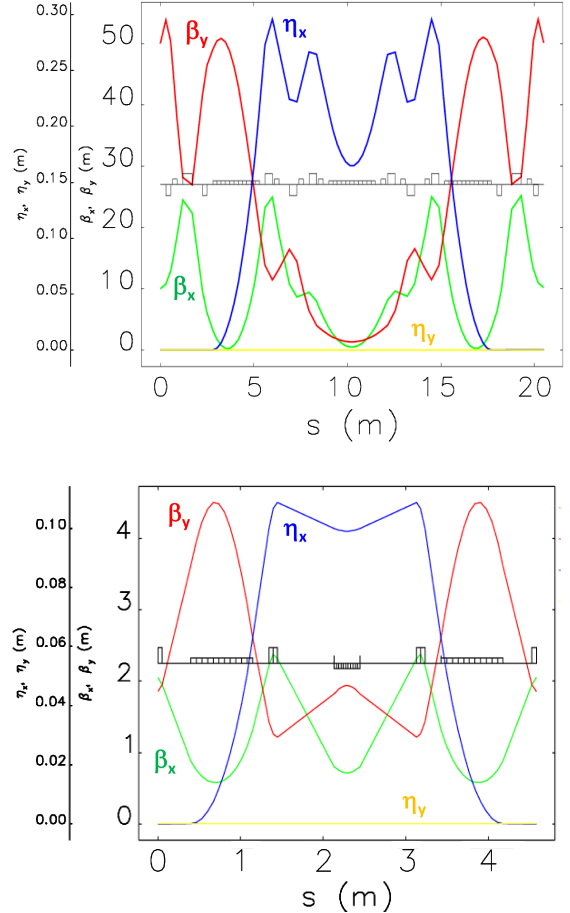
1.FIG. 2. Betatron and dispersion functions along one cell of the arc compressor (top; CA, DA in Fig. 1) and of the isochronous arc (bottom; IA, EA in Fig. 1). In gray, dipole (long small rectangles) and quadrupole magnets (short tall